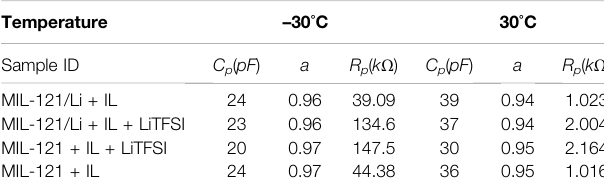
TABLE 2 | Parameters obtained by fi tting the impedance semicircles in Figures 3B,C )withaconstantphaseelement(CPE)inparalleltoaresistor R p . C p isthe capacitance and a is the exponent of the